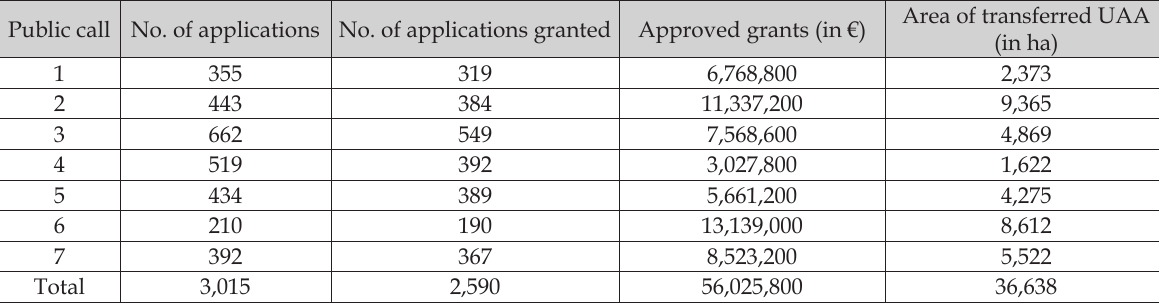
Table 2. General characteristics of the rDP measure of setting-up young farmers.